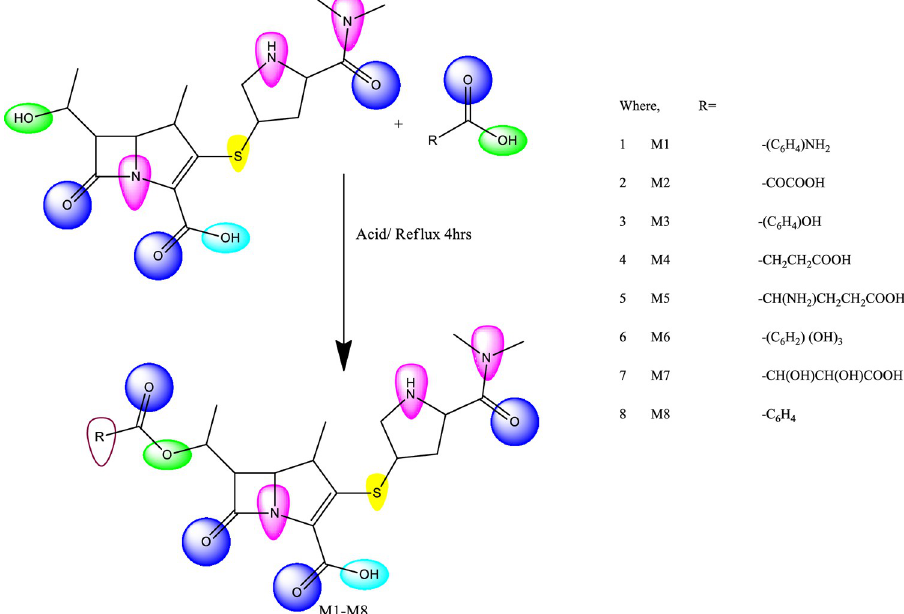
Fig 1. Schematic diagram for synthesis of ester derivatives of 3-((5-(dimethylcarbamoyl) pyrrolidin-3-yl) thio)-6- (1-hydroxyethyl)-4-methyl-7-oxo-1-azabicyclo[3.2.0] heptane-2-carboxylic acid.